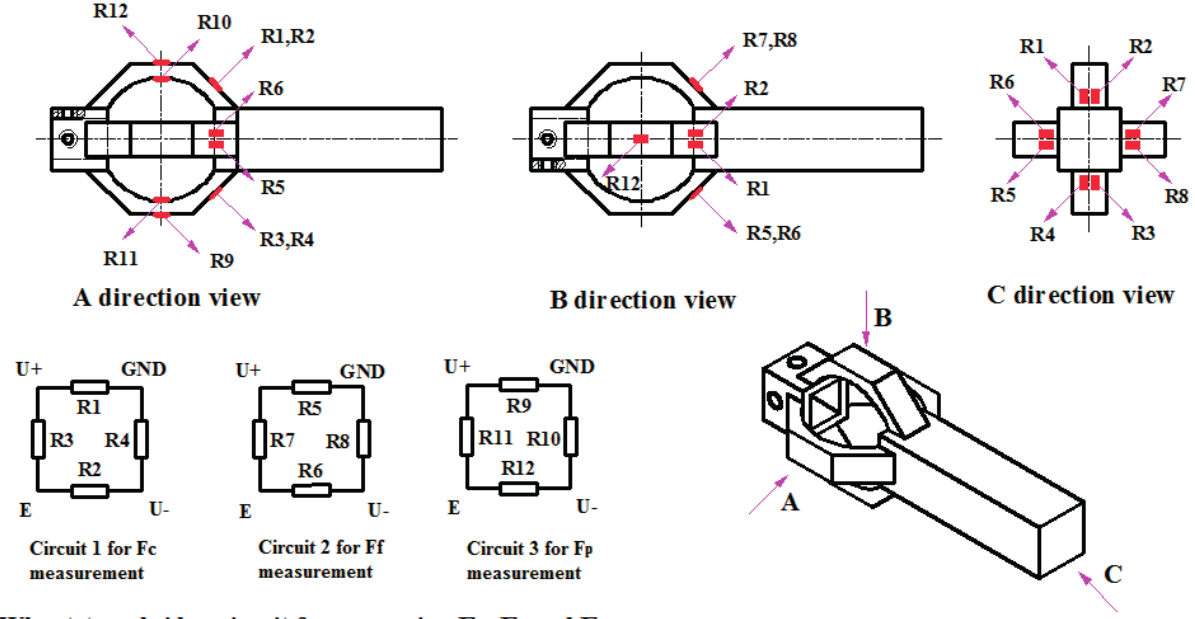
Figure 5. Locations of strain gauges and organization of Wheatstone full bridge circuits.